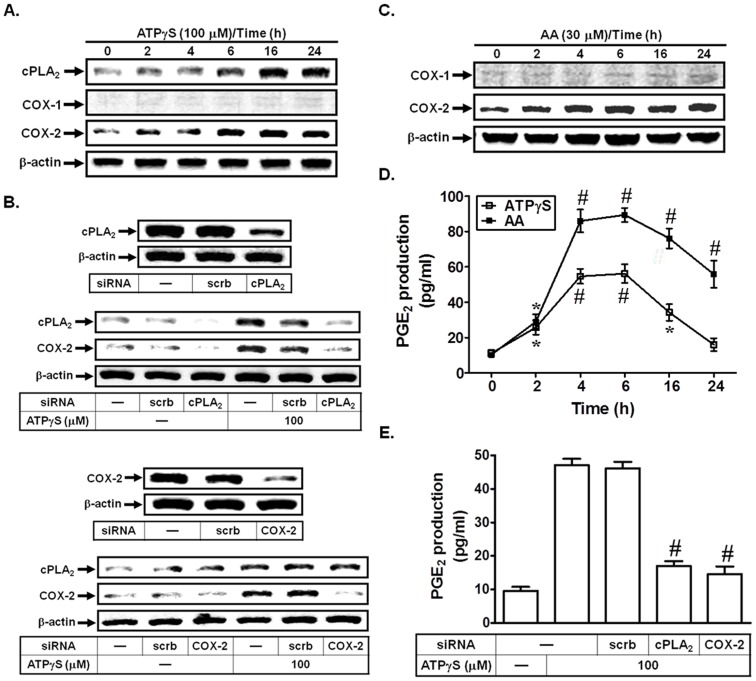
ATPγS induces COX-2 expression via a cPLA2/AA signaling.(A) Cells were treated with ATPγS for the indicated times. The expression of cPLA2, COX-2, or COX-1 was determined by Western blot. (B) Cells were transfected with cPLA2 or COX-2 siRNA, and then treated with ATPγS for 24 h or 6 h. The expression of cPLA2 or COX-2 was determined by Western blot. (C) Cells were treated with AA for the indicated times. The expression of COX-2 or COX-1 was determined by Western blot. (D) Cells were treated with ATPγS or AA for the indicated times. The production of PGE2 was measured. (E) Cells were transfected with cPLA2 or COX-2 siRNA, and then treated with ATPγS for 6 h. The production of PGE2 was measured. Data are expressed as mean±S.E.M. of three independent experiments. #
p<0.01, as compared with the cells exposed to vehicle alone (D) or scrambled siRNA+ATPγS (E).